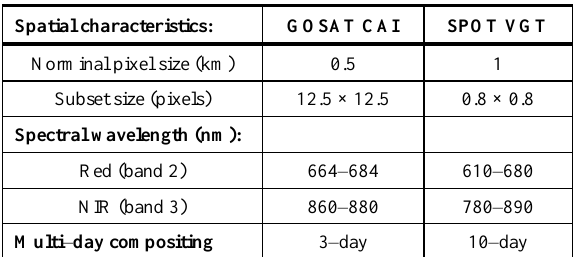
Table 1. Characteristics of GOSAT CAI and SPOT VGT NDVI datasets